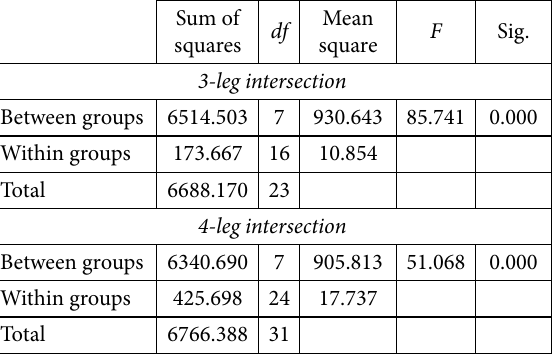
Table 7. ANOVA per second of RLR after red-light onset